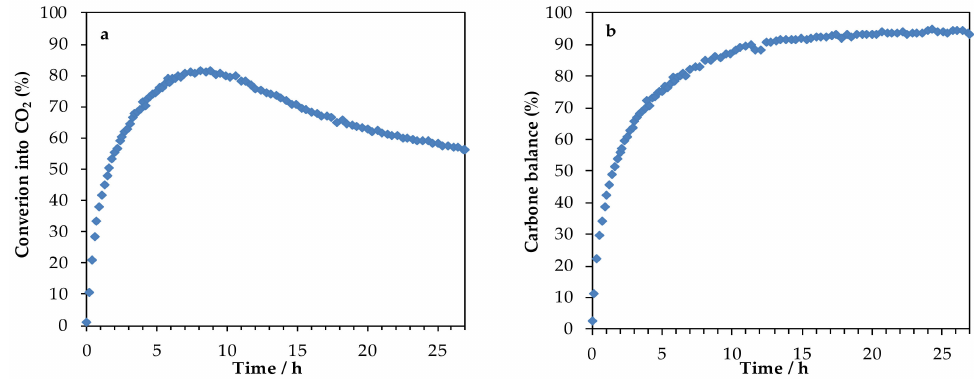
Figure 13. ( a ) Stability test performed for 27 h at 135 ◦ C after the regeneration step and ( b ) Carbon balance over the Mn10Hap